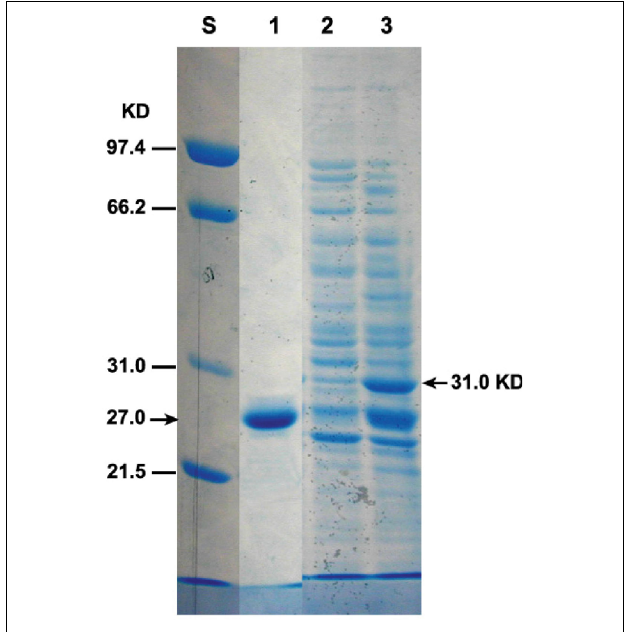
FIGURE 7 | SDS-PAGE of KM71- gfp-tmf A transformed cells. Each lane contains equal amount of proteins extracted from equal number of cells (1.6 × 10 7 ) and separated by SDS-PAGE. Protein were stained with Coomassie Blue. Marker protein of known size were run on the left lane (S). Lane 1 standard GFP (27.6 kDa), lane 2 protein extracted from non-stimulated cells, Lane 3 cells stimulated with 0.5% methanol for 93 h. GFP-TMOF expected protein band (31 kDa) is indicated with an arrow on the right. Fermentation (h)